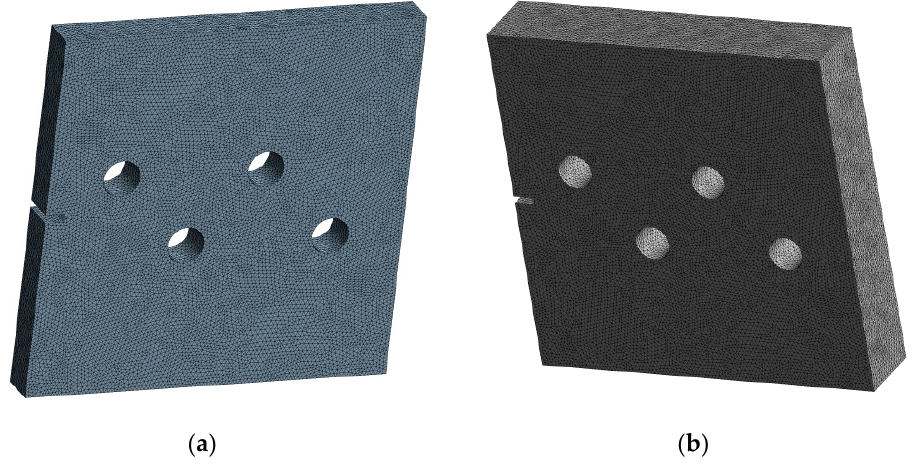
Figure 2. Initial mesh: ( a ) 10 mm thickness, ( b ) 20 mm thickness.